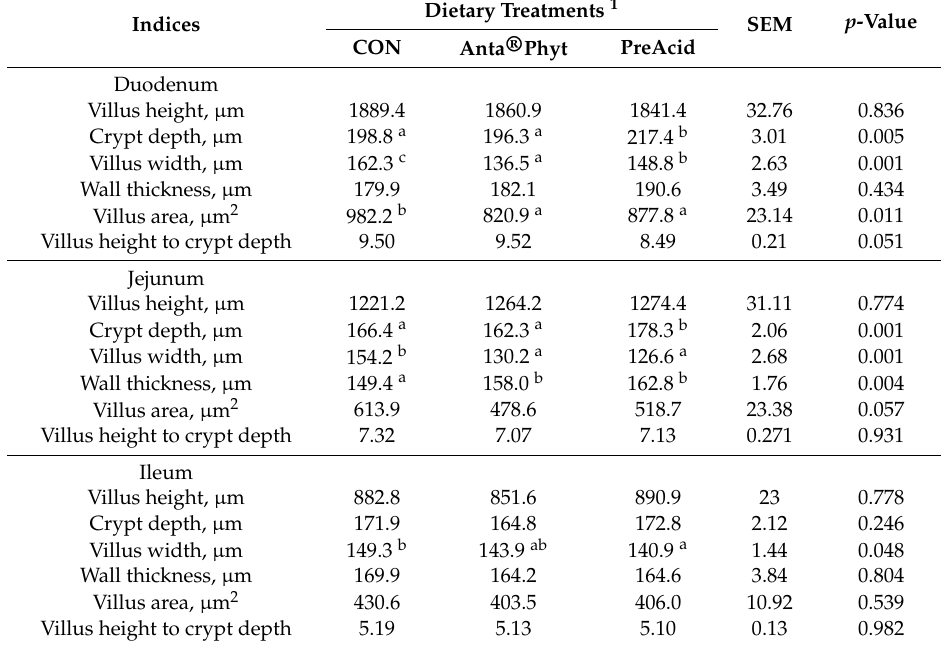
Table 3. E ff ect of dietary treatments on morphological indices of the duodenal, jejunal, and ileal mucosa in 35-d-old chickens.